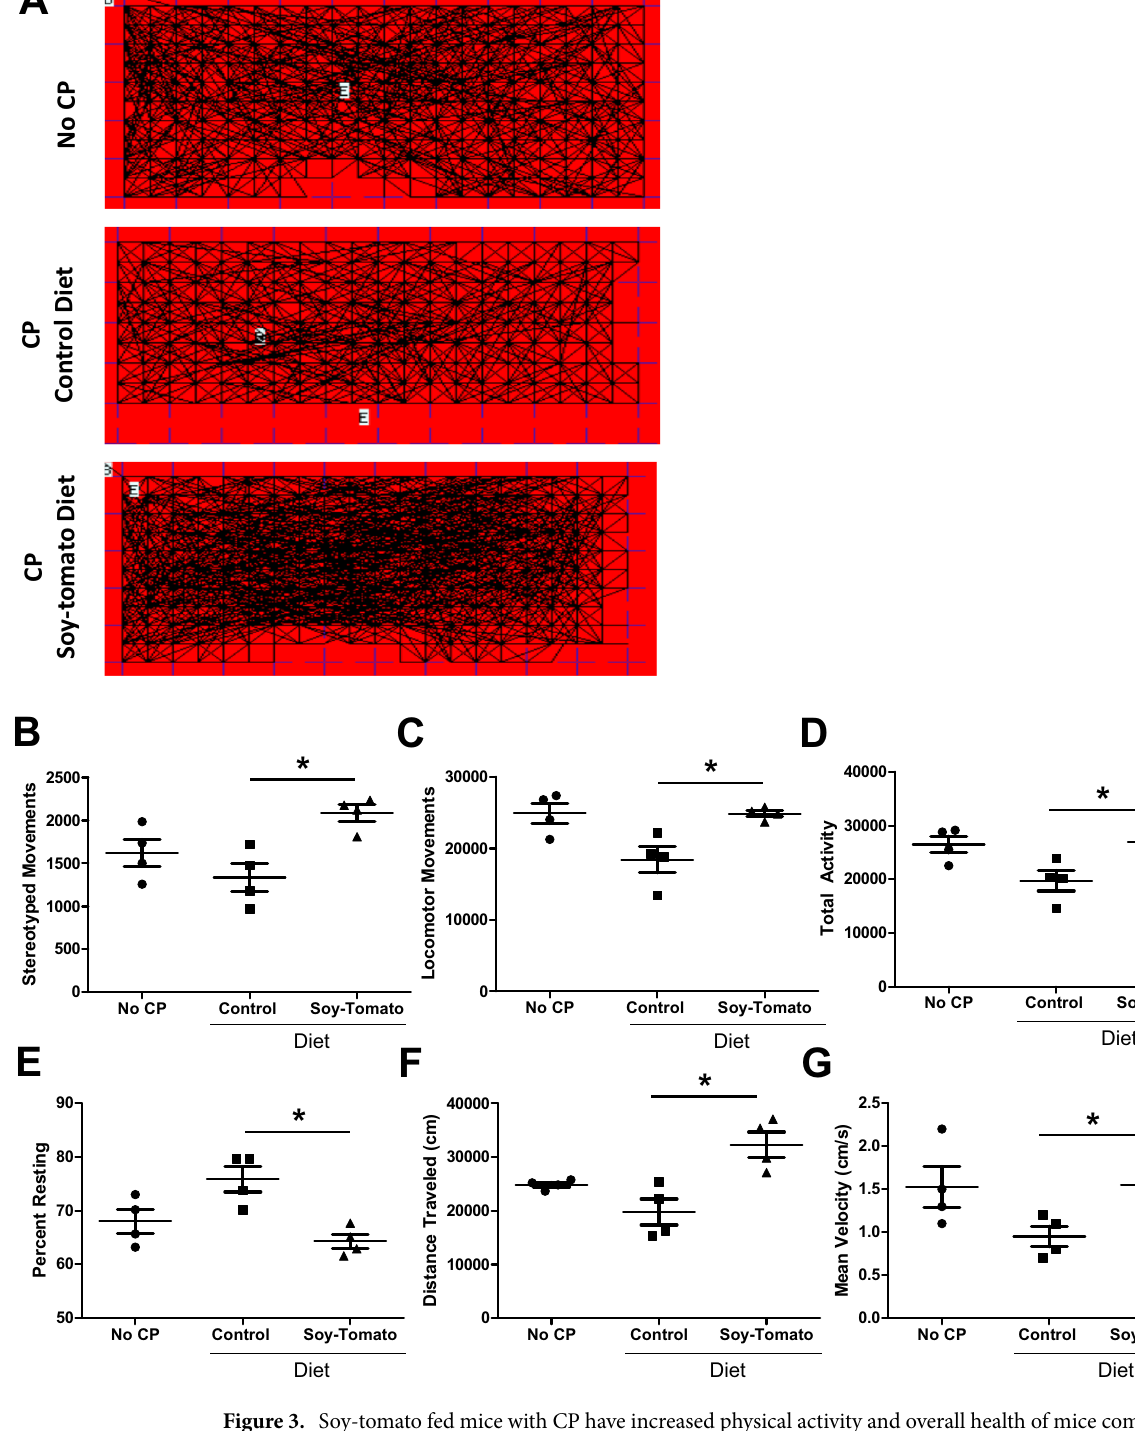
Figure 3. Soy-tomato fed mice with CP have increased physical activity and overall health of mice compared to control diet. Four days prior to study endpoint, activity levels of mice in each group (No CP, CP on control diet, and CP on a soy-tomato diet) were measured using an infrared-based sensing system. ( A ) Representative movement tracks for individual mice from each group for the first 2 h of the measurement interval. Quantified data for ( B ) stereotyped movement, ( C ) locomotor movement, ( C ) total activity, ( D ) percent of time resting, ( E ) distance traveled, and ( F ) mean velocity over a 6 h period was assessed. N = 4 mice/group, * p <